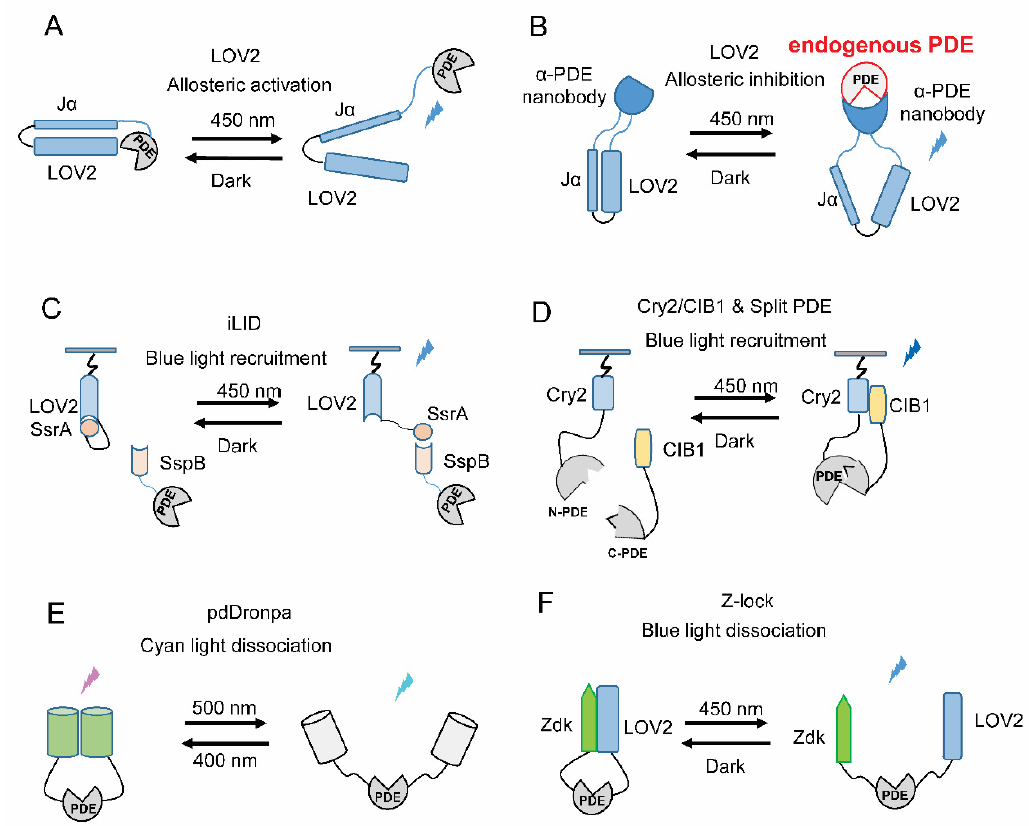
Figure 4. Potential strategies to design new light-regulated PDEs. ( A ) LOV2 based allosteric activation: tight linkage to the LOV domain can block the function of PDE, while the light-induced conformational changes in the LOV domain recover its function. ( B ) LOV2 based allosteric inhibition: LOV2 domain fused at the loop area of anti-PDE single domain antibody ( α -PDE nanobody), blue light illumination triggers conformational changes in the nanobody, leading to binding of nanobody to PDE and inhibiting or regulating endogenous PDEs. ( C ) Light-mediated translocation with iLID (LOV2-SsrA/SspB) system. The LOV2-SsrA part can be tethered to membrane fractions in certain organelles. Targeted PDEs could be fused to the corresponding dimeric partner SspB. This could potentially achieve the recruitment of PDEs to a certain subcellular compartment by light illumination. ( D ) Reconstitution of Split PDE fragments. Two split fragments N -PDE and C -PDE are fused with Cry2 and CIB1, respectively. Blue light can induce the dimerization of Cry2/CIB1 and recover the full PDE hydrolysis activity. ( E ) pdDronpa system: The catalytic domain of PDE are fused with two pdDronpa proteins in N - and C -terminus or other proper positions. Cyan light-induced dissociation free the active site of PDE while violet light-triggered association block the active site. ( F ) Z-lock system: Zdk and LOV2 are fused at the N - and C -terminus or other proper positions of PDE, blocking PDE active site in dark. After blue light illumination, Zdk and LOV unlinked, uncaging the active site. LOV: light-oxygen-voltage; iLID: improved light-induced dimer; Cry2: cryptochrome 2; CIB1: cryptochrome-interacting basic-helix-loop-helix 1.